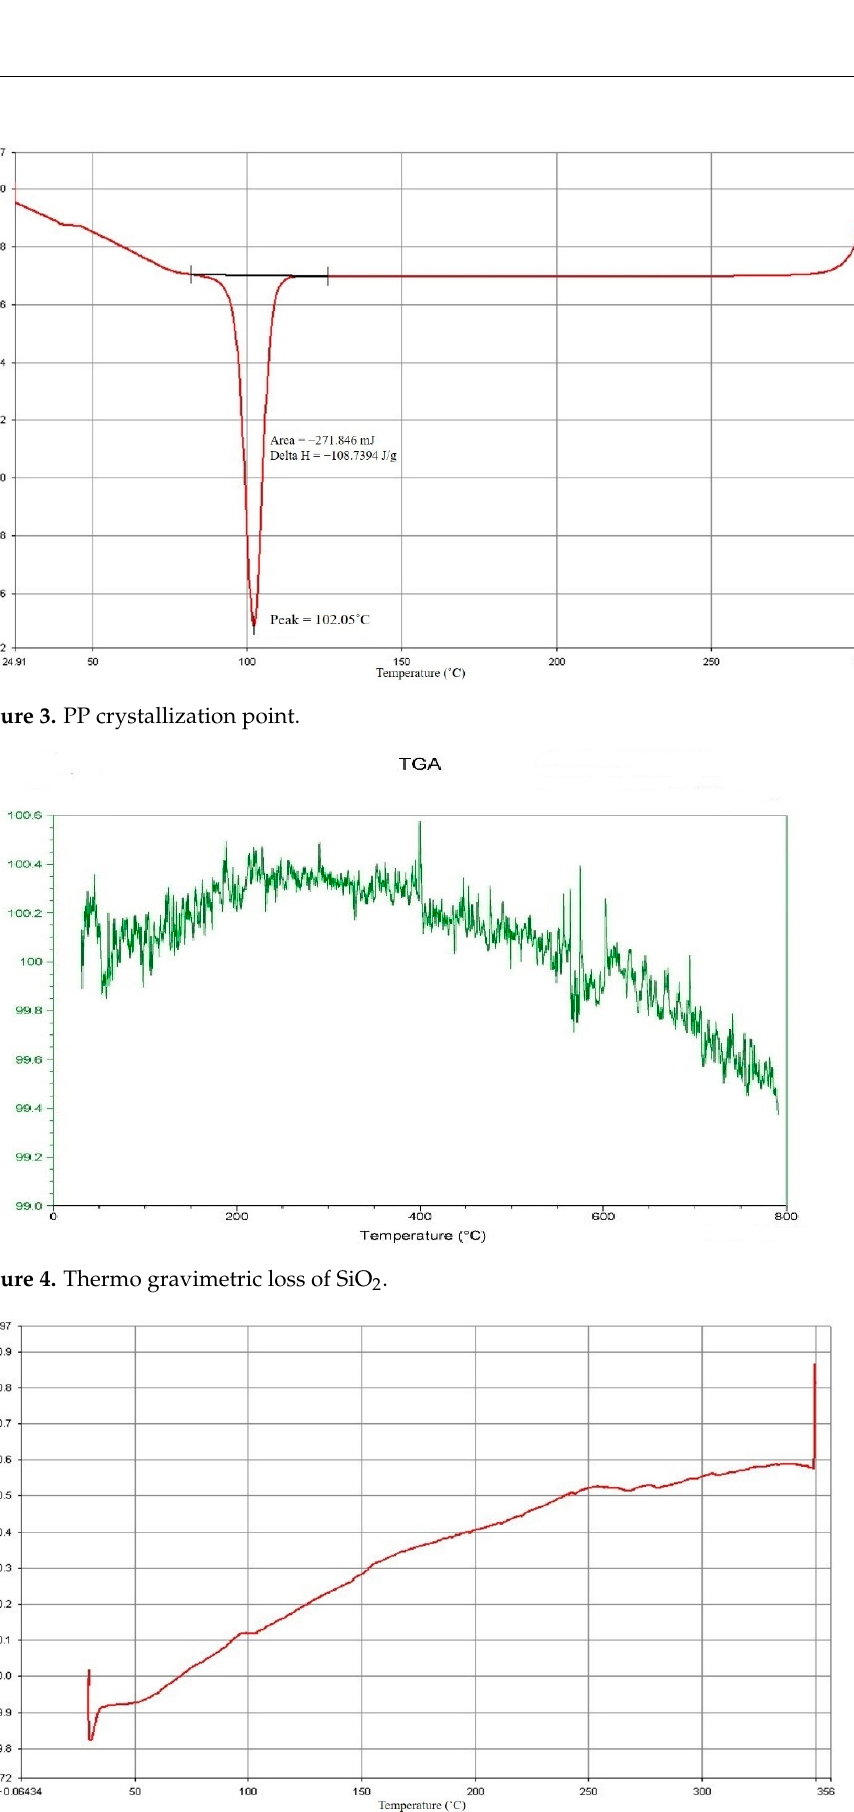
Figure 5. Thermal differential analysis of SiO 2.